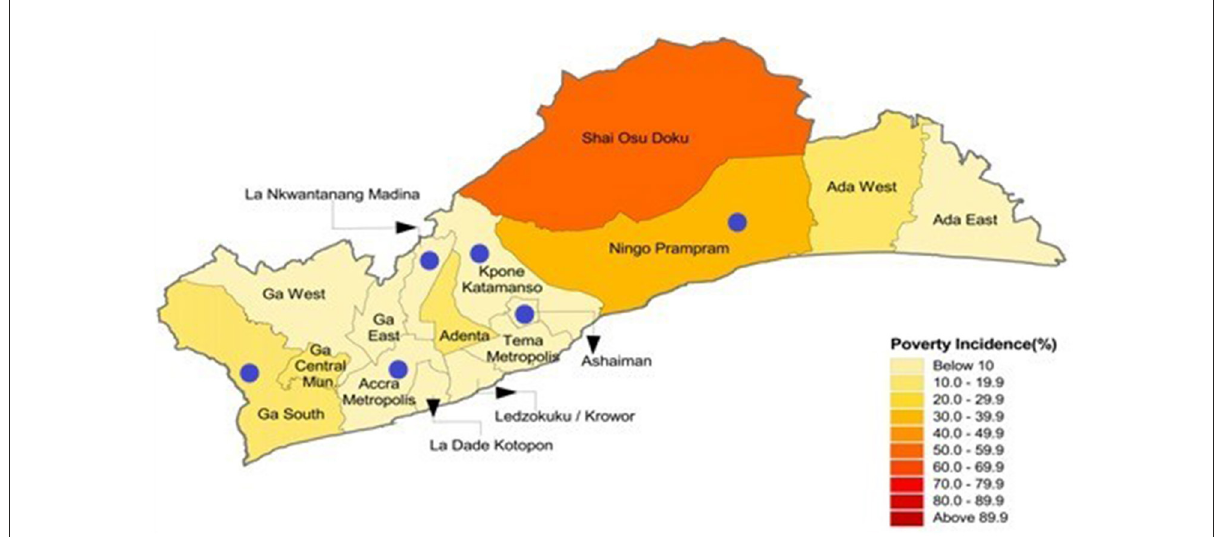
FIGURE1 A map of the Greater Accra Region of Ghana highlighting the six selected districts and their poverty